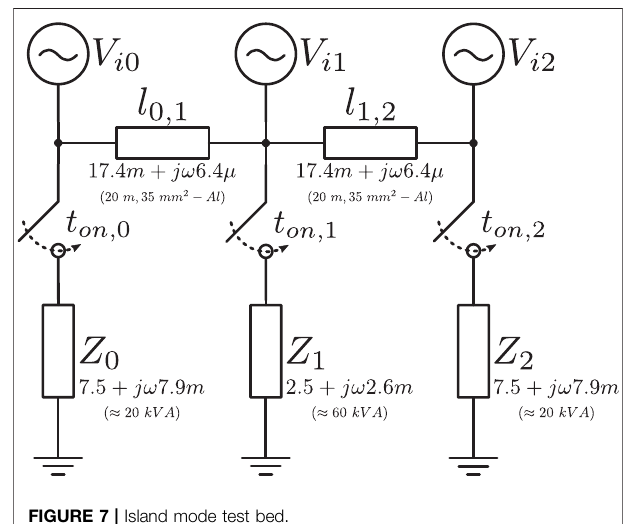
FIGURE 7 | Island mode test bed.